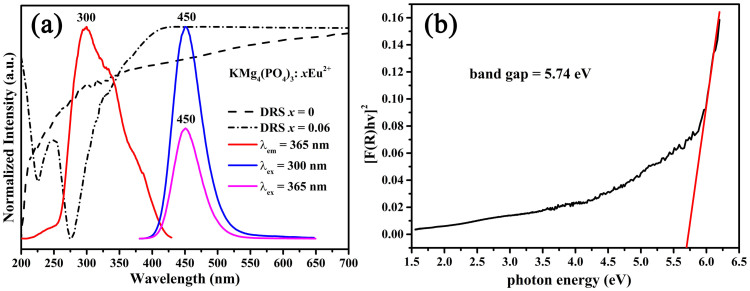
(a) Excitation and emission spectra of KMg4(PO4)3:0.06Eu2+ (λem = 450nm for excitation and λex = 300 and 365nm for emission); Diffuse reflection spectra of KMg4(PO4):xEu2+ (x = 0 and 0.06); (b) Absorption spectra of KMg4(PO4)3:0.06Eu2+ matrix calculated by the Kubelka−Munk equation. All spectra were taken at RT.